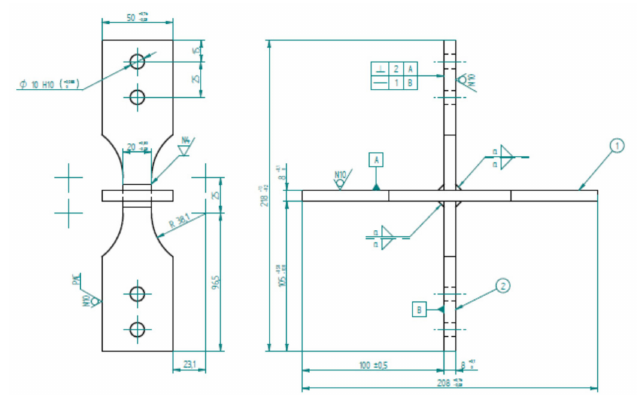
Figure 2. Geometric fixture test (mm scale).